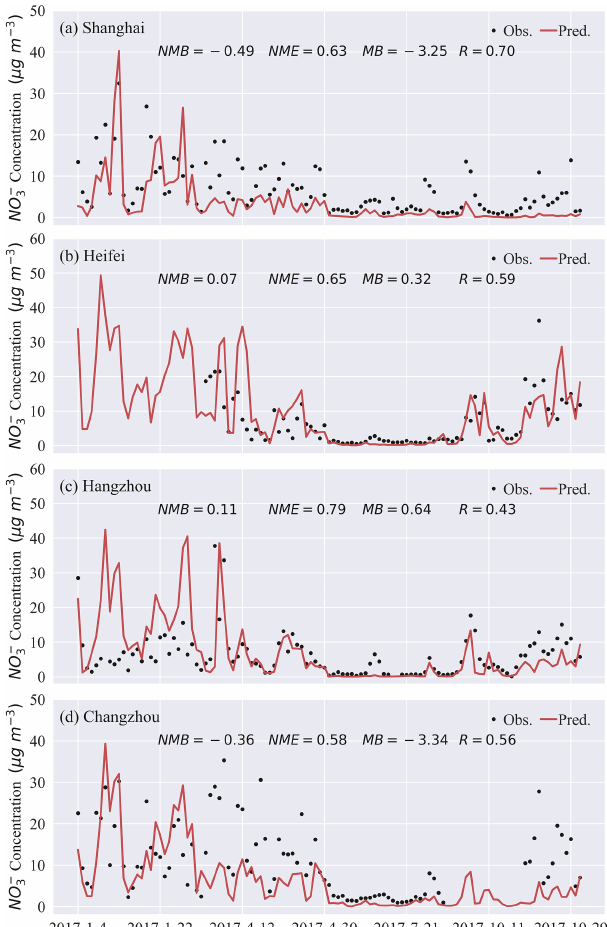
Figure 2. Time series of predicted (red) and observed